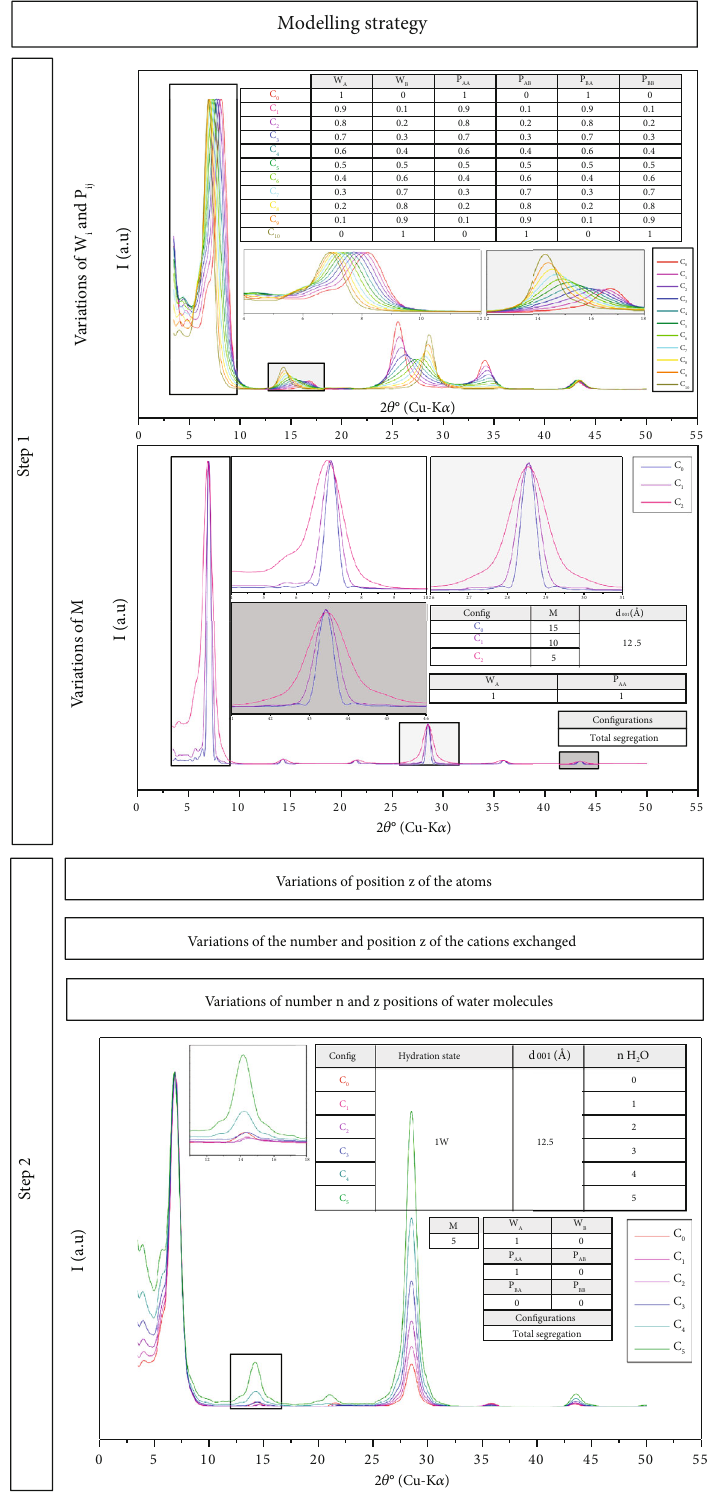
Figure 4: The main input structural parameter for the XRD modeling